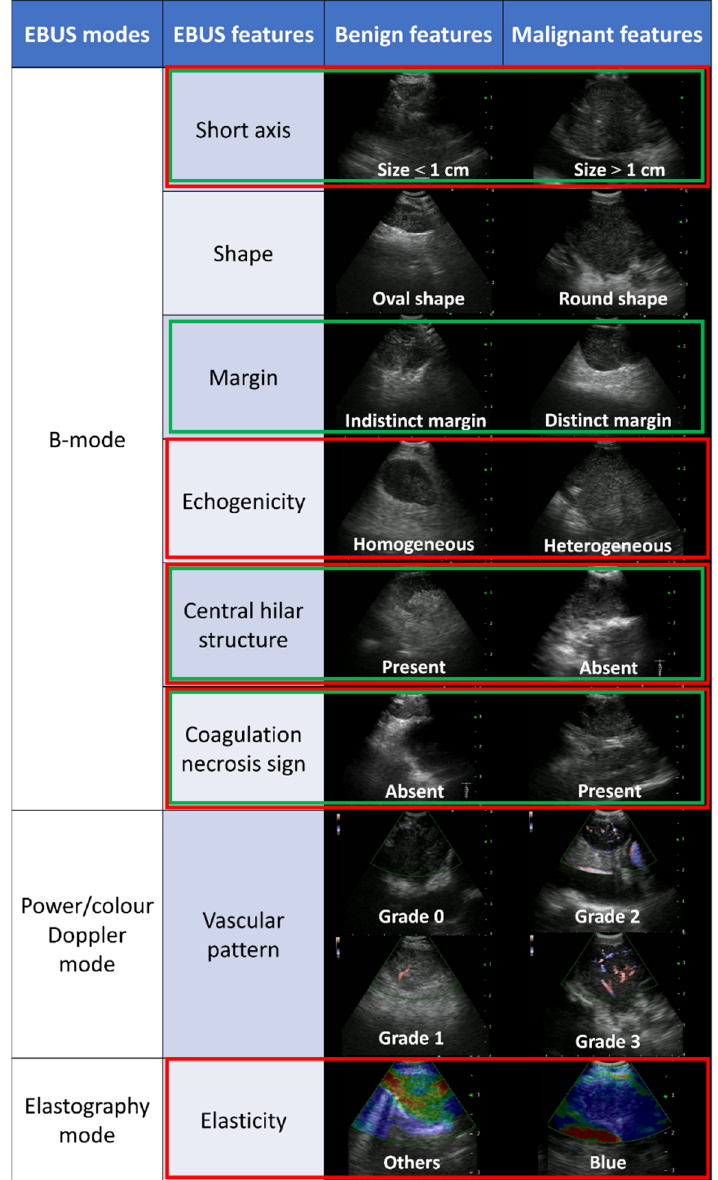
Figure 1. Representative endobronchial ultrasound (EBUS) features suggestive of benign and malignant lymph nodes in each EBUS mode and EBUS features included in each scoring system. In total, eight EBUS features were evaluated; four features surrounded by the green square show the Canada lymph node score, and five features surrounded by the red square show the novel scoring system.